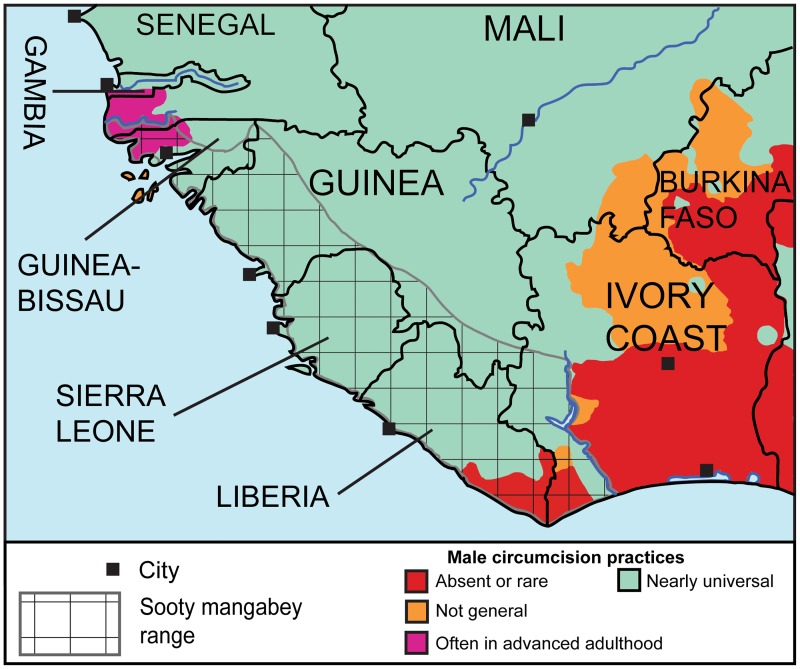
The spread of MC practices at or near the sooty mangabey range in early 20th century.The information supporting this map is in S2 Dataset, with additional explanations in S1 Text. The checkered area indicates the historical (pre-1950) range of sooty mangabeys [51–53].